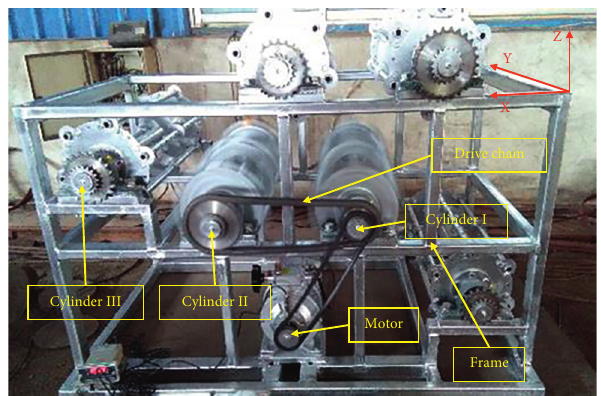
Figure 3: Isometric model of the combine harvester parallel